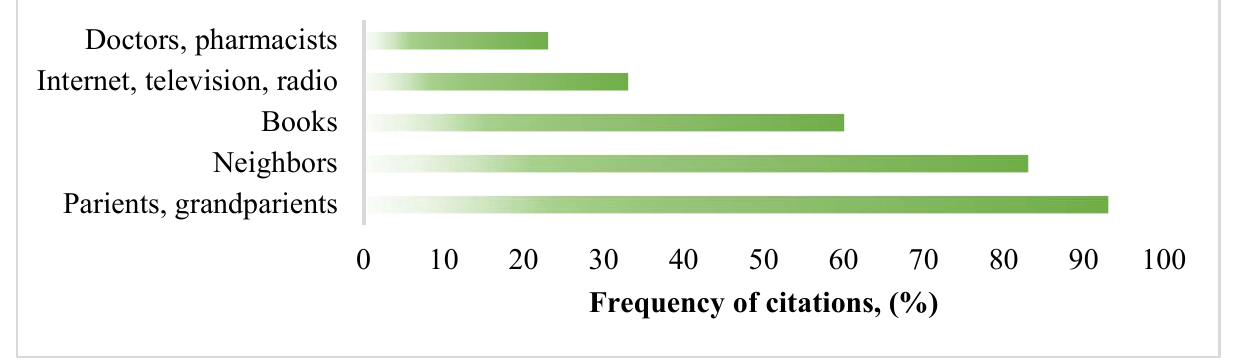
Figure 2. The ethnopharmacological information sources of the respondents .